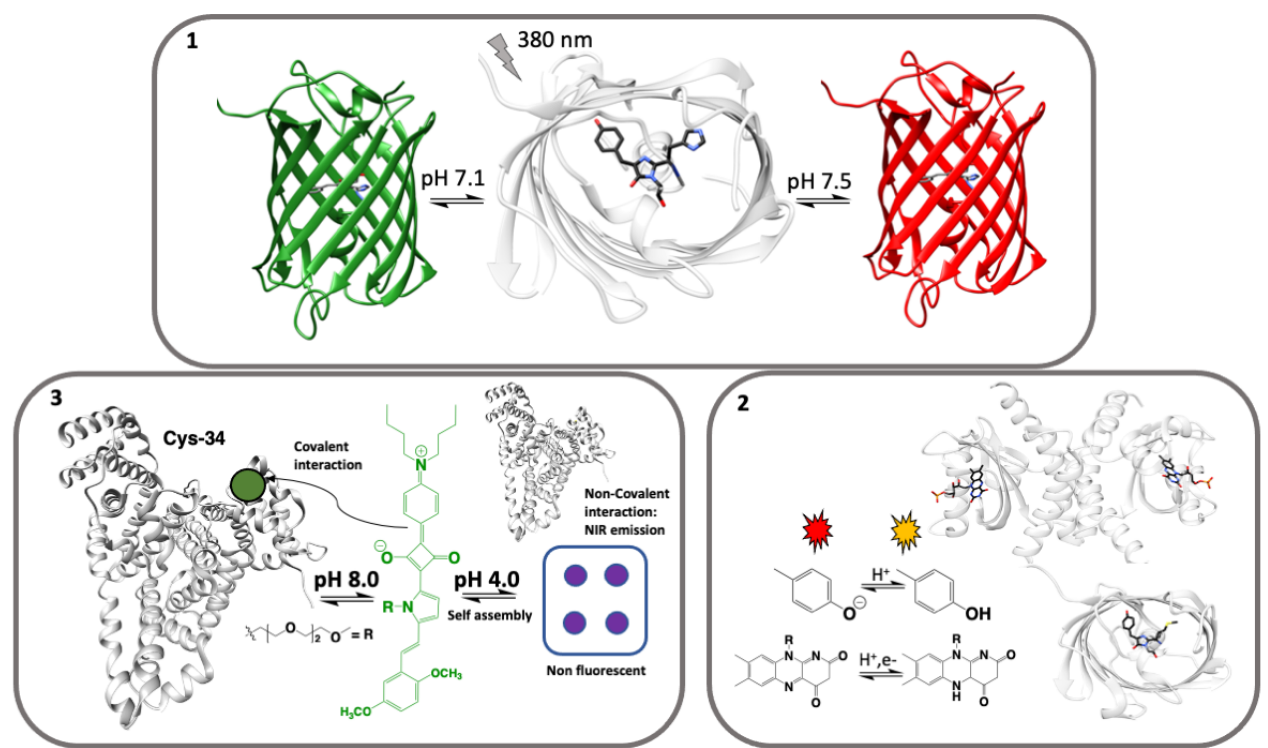
Figure 3. Bioengineered visual pH sensors. Box 1. Ribbon plot of Dendra2 protein [129]: chromophore appears as sticks (middle figure, nitrogen blue, oxygen red), accession code 2vzx [124]. Box 2. Ribbon plot representation of chimeric protein pHaROS [130] comprised of LOV protein, bound to its cofactor FMN (sticks), accession code 4hj3 [131], and GFP variant of mkate , accession code 3rwa [132]. A peptide linker is connecting LOV to mkate variant. Figure made with “UCSF Chimera” [133] for rendition purpose only and neither derived from experimental determination, nor theoretical calculation. Chemical structures of chromophore’s phenol group and flavin mononucleotide are represented. Box 3. Ribbon plot of bovine serum albumin, accession code 4f5s [134]. Under basic condition the sensor is linked to the side chain of Cys-34 and green fluorescence is produced [135,136]. Under acidic condition, the sensor can self-assemble (purple spheres) producing a non-fluorescent aggregate. Adapted from references indicated in square brackets.